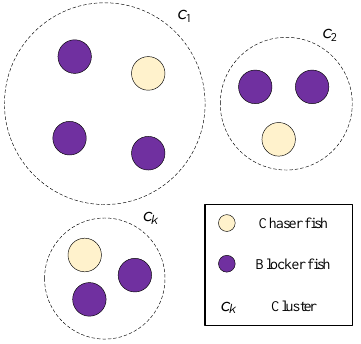
Figure 10. Graphical view of the goatfish population.